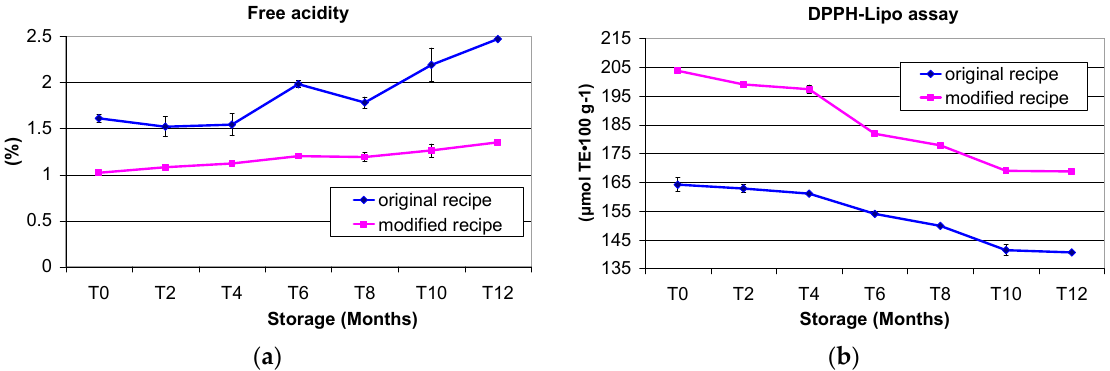
Figure 4. ( a ) Free acidity levels of fat samples extracted from Italian Cantuccini biscuits prepared with the original recipe and the modified recipe during one year’s shelf-life. ( b ) DPPH-Lipo assay results for fat samples extracted from Italian Cantuccini biscuits prepared with the original recipe and the modified recipe during one year’s shelf-life.